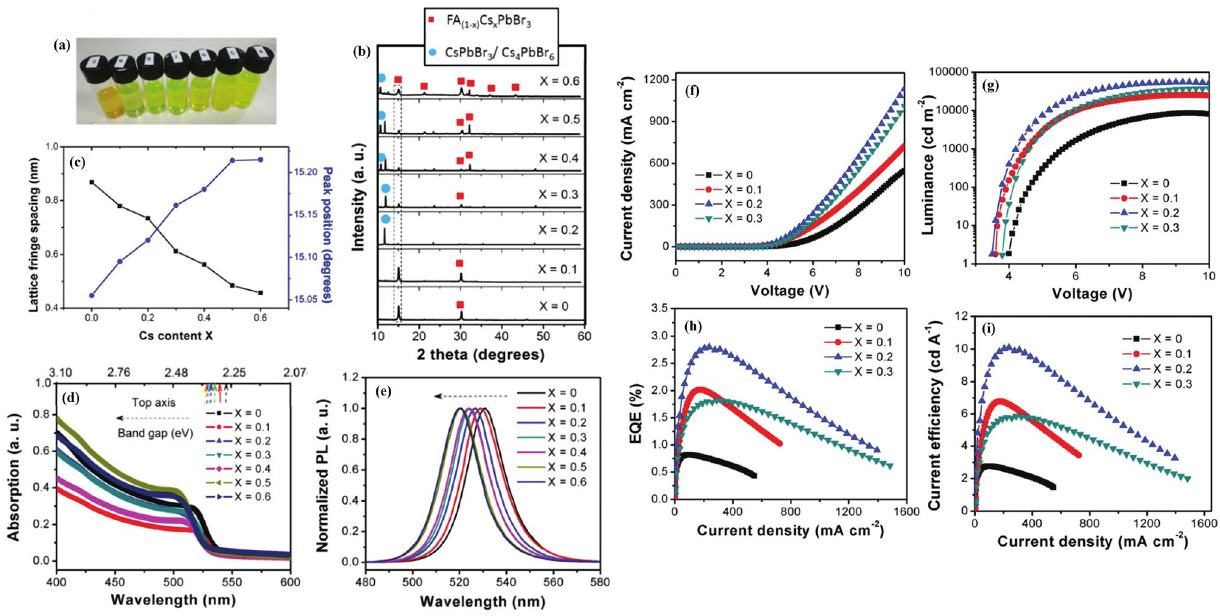
Fig. 2 a Photographs of different perovskite NCs in solution. b XRD f J–V g luminance–voltage, h EQE–current density, and i current patterns of FA efficiency–current density characteristics of perovskite LEDs, based Cs PbBr (x = 0–0.6). c Lattice fringe and peak (1−x) x 3 position (≈15°) as a function of Cs content, x, in FA CsxPbBr . d (1–x) 3 Absorption spectra and e PL spectra of FA CsxPbBr (x = 0–0.6). (1−x) 3